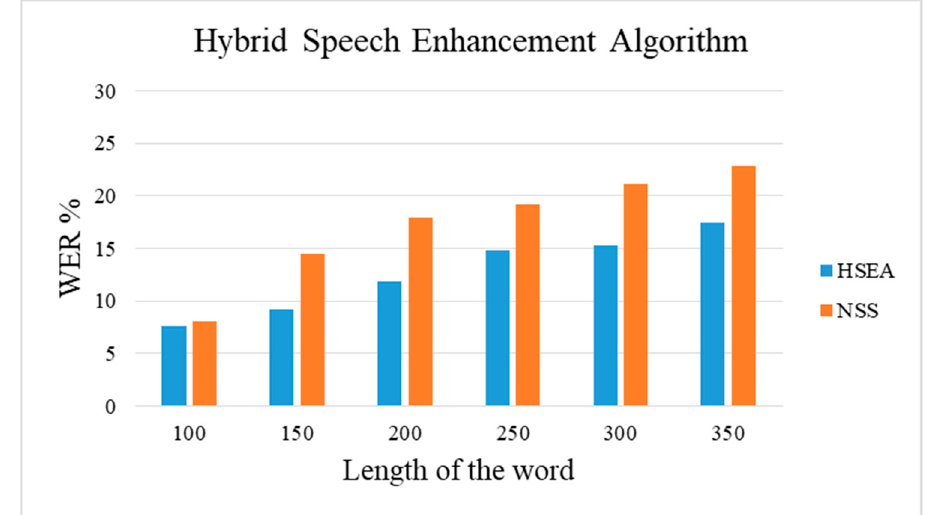
Figure 12. Performance of HSEA for RAVDESS.